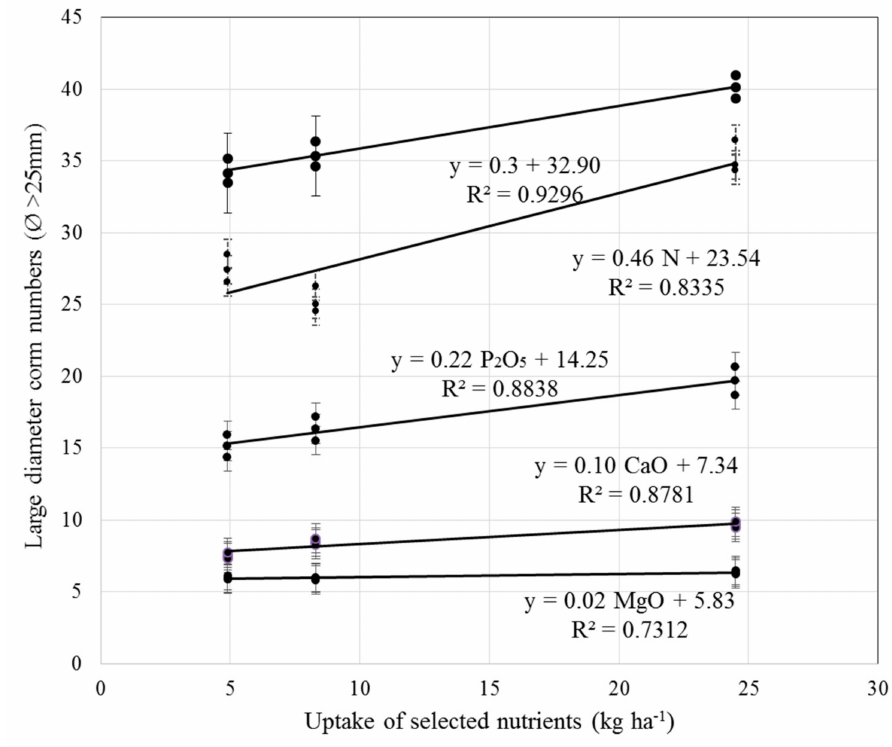
Figure 3. Linear relationship between uptake of selected nutrients (kg · ha − 1 ) and number of corms with a diameter above 25 mm